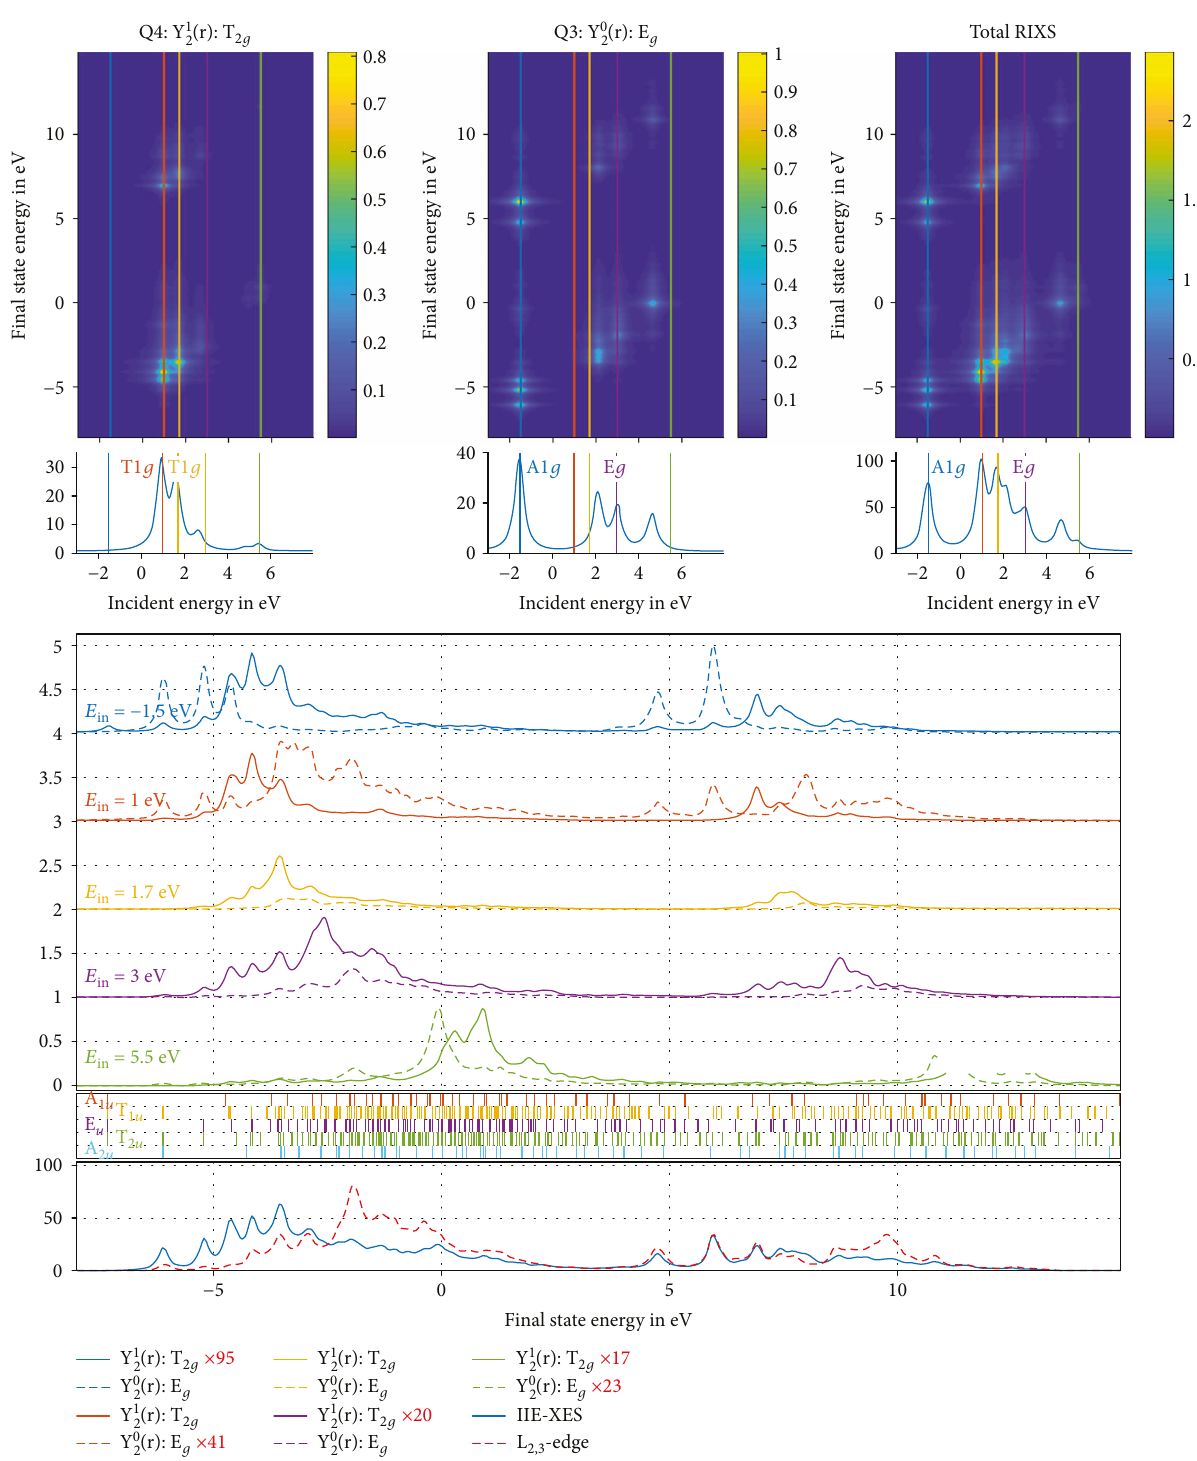
Figure 33: Calculated 1s2p RIXS map for Mn 3+ ( 3d 4 ) with a crystal fi eld for 10D q = 1 5 eV re fl ecting the high spin case. As can be seen by the two RIXS maps (top row, left and middle), the contributions are in agreement with the predicted symmetries found in (51) and